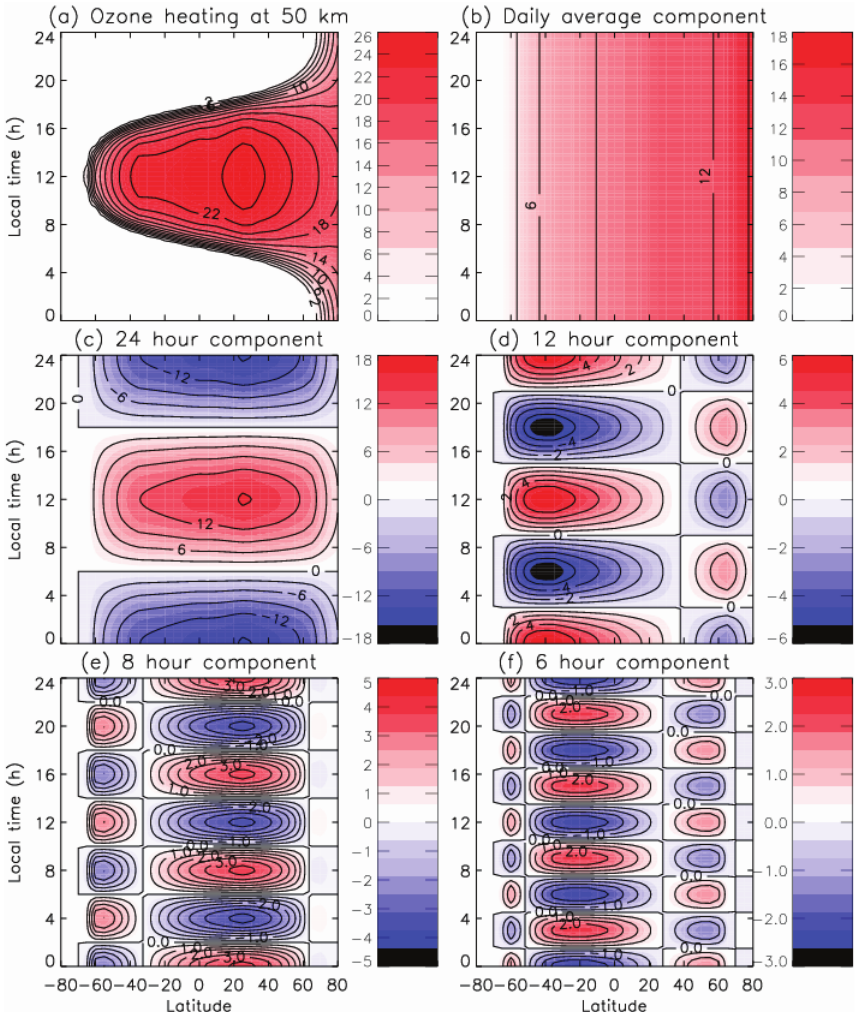
Fig. 8. Local time-latitude cross sections of the total ozone heating rate (a) and daily mean (b) , diurnal (c) , semidiurnal (d) , terdiurnal (e) , and 6-h (f) components of heating at the altitude of 50km on day 170 in